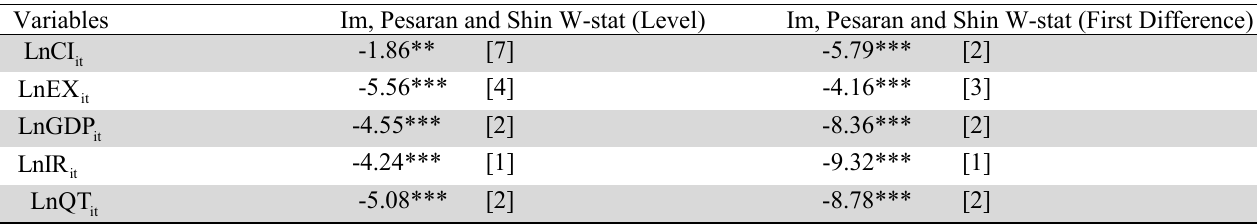
Results of Panel Unit Root test